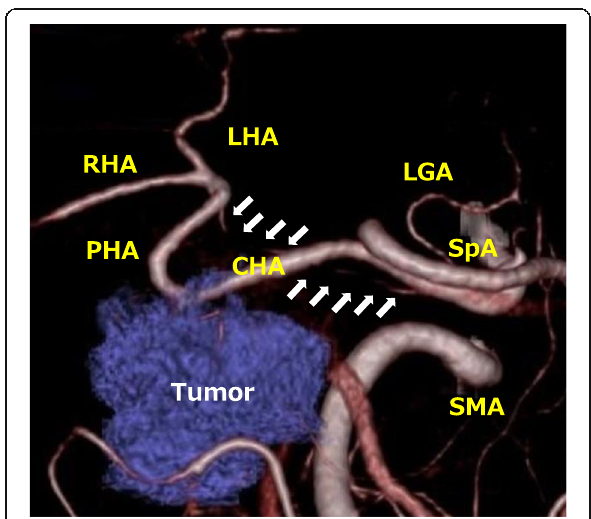
Fig. 2 Three-dimensional CT angiography showed anastomosis between the root of the CHA and PHA (white arrow). RHA, right hepatic artery; LHA, left hepatic artery; LGA, left gastric artery; SpA, splenic artery; SMA, superior mesenteric